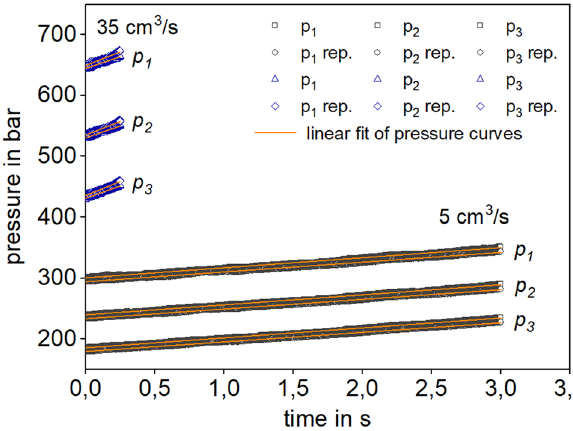
Figure 5: Reproducibility of pressure acquisition within the relevant fi lling phase for PLA + DCUP at 200°C and 0.25 wt% N